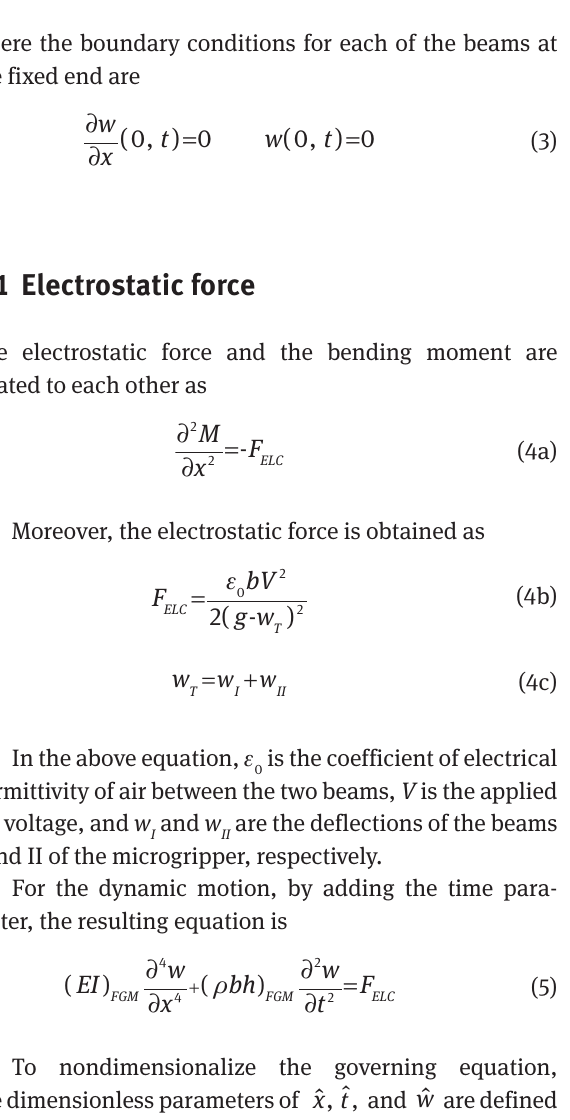
Figure 1 Schematic view of FGM